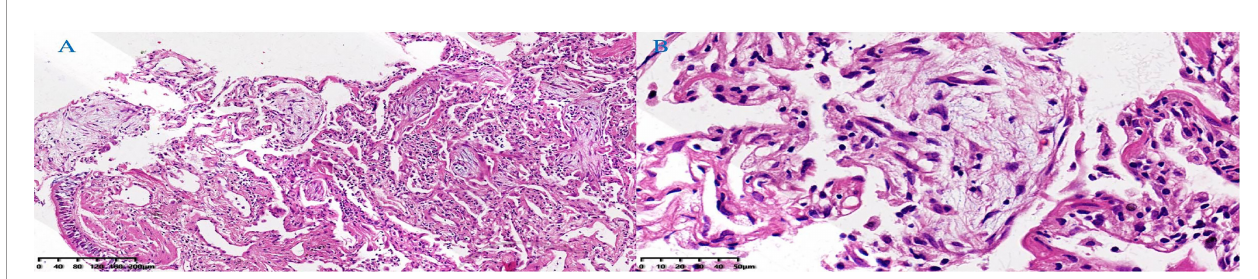
recurrence until last follow up in Nov 11, 2021 ( Figure 1F ).